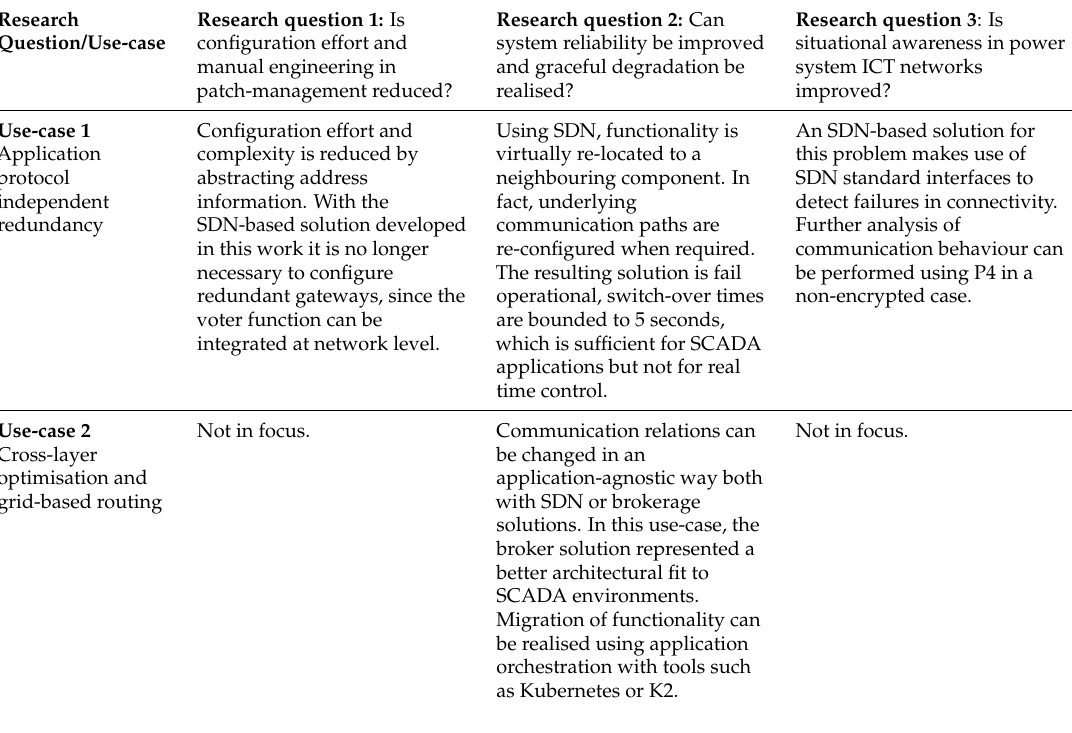
Table 1. Answers to the research questions gained from the use-cases